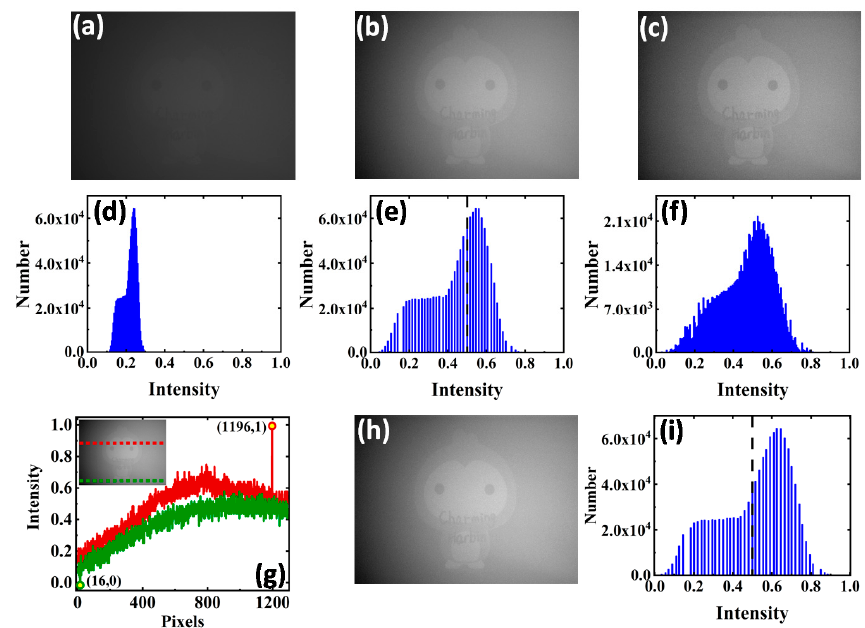
Figure 5. ( a ) is the raw intensity image I min ; ( b ) is the result of processing ( a ) using Li’s method [25]; ( c ) is the result of processing ( a ) using CLAHE [11]; ( d ) is the normalized grayscale histogram of ( a ); ( e ) is the normalized grayscale histogram of ( b ); ( f ) is the normalized grayscale histogram of ( c ); ( g ) is the grayscale value row indexes of the extreme points in ( b ); ( h ) is ( b ) the grayscale normalization result after removing the extreme point; ( i ) is the normalized grayscale histogram of ( h ). It is worth noting that the image acquired in the highly turbid water contains a large amount of noise, which may cause some grayscale extreme points in the image. Therefore, the histogram stretching operation for the grayscale normalization of I min using Li’s method will be disturbed. Figure 5g shows the row indexes of the grayscale values in Figure 5b that are through the minimum (green line) and the maximum (red line), and the